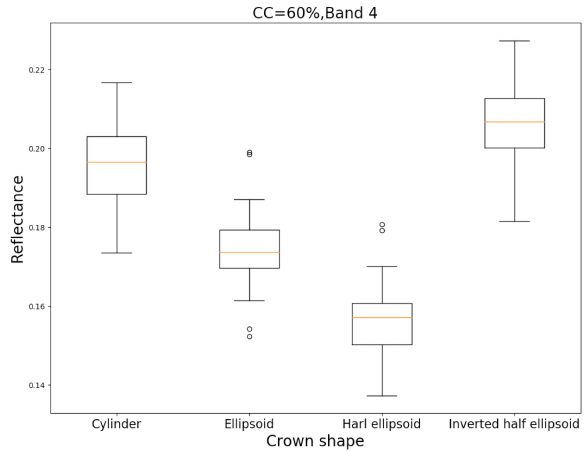
Figure 6. Reflectance difference due to canopy shape when CC is 60%. The difference beteween an inverted half-ellipsoid and a half-ellipsoid is about 1.3